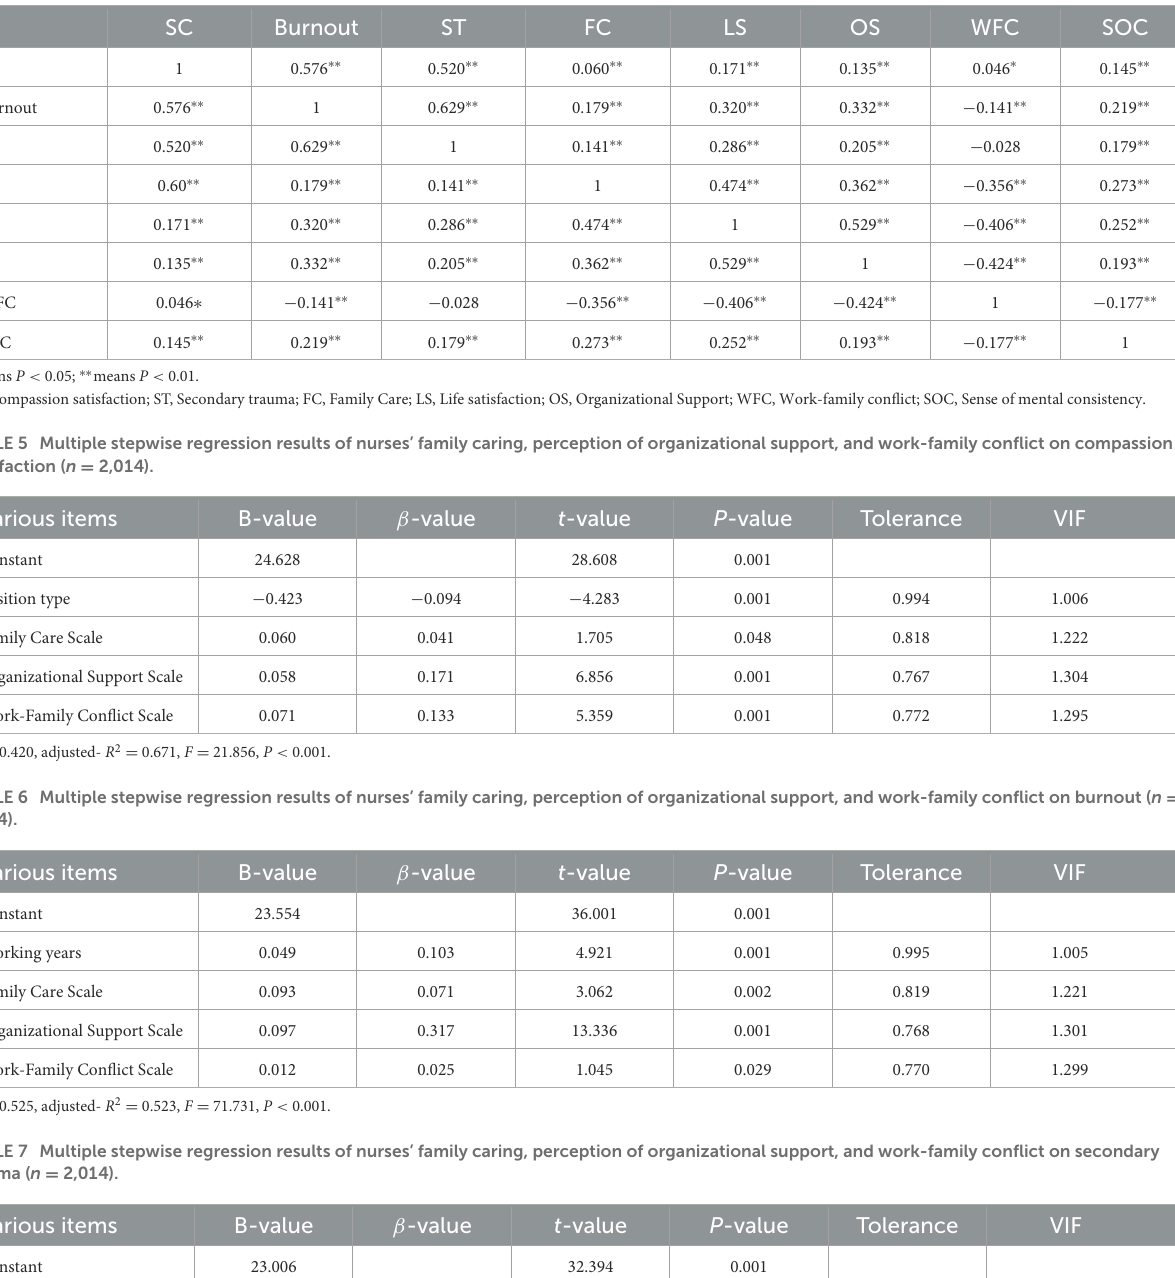
TABLE 4 Correlation analysis of nurses’ family care, organizational support and nurses’ professional quality of life.